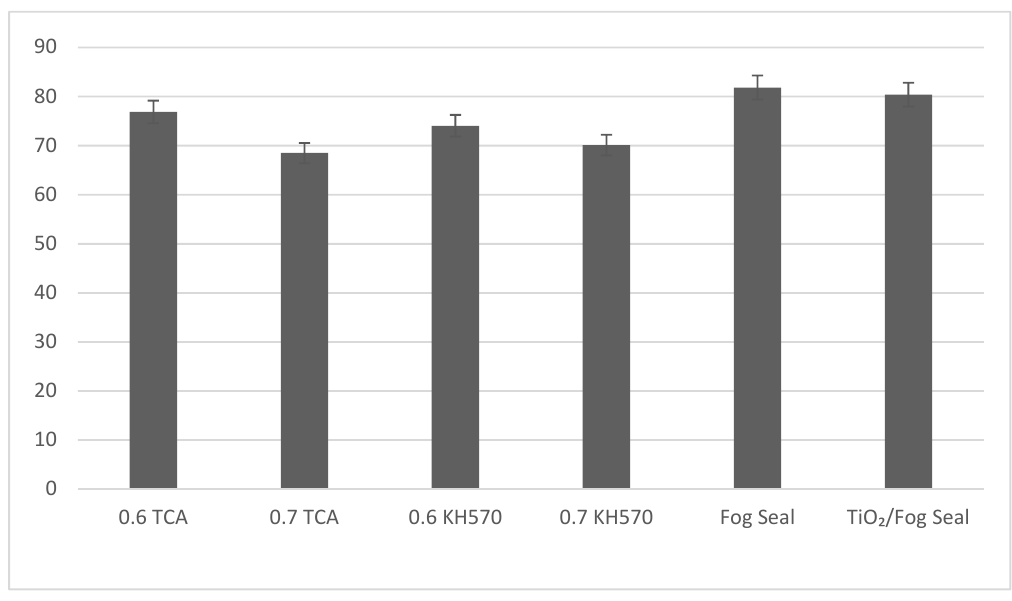
Figure 15. BPN value of different composite materials.